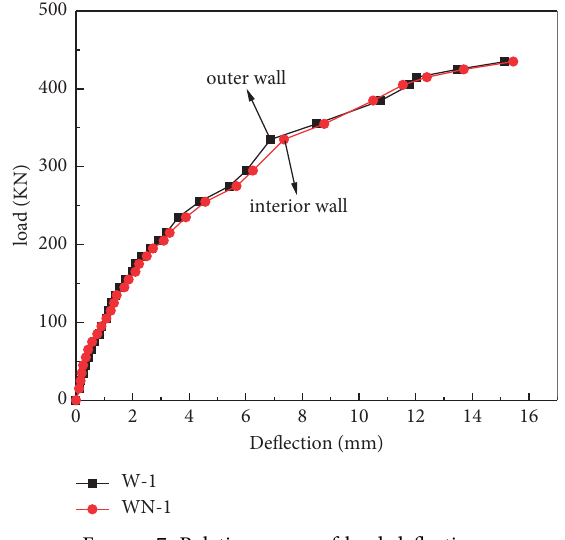
Figure 7: Relation curve of load-deflection.